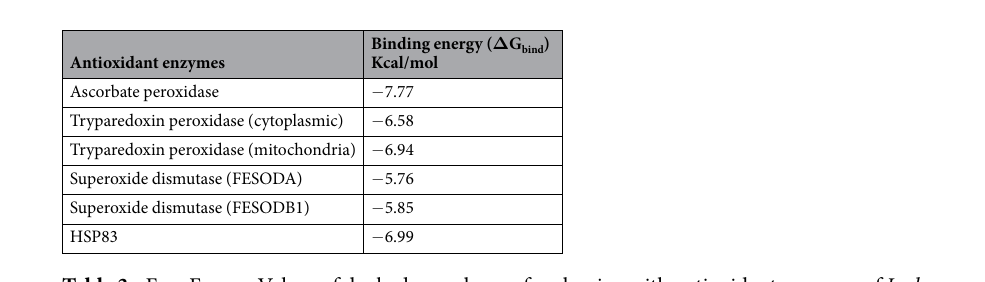
Table 3. Free Energy Values of docked complexes of mahanine with antioxidant enzymes of L. donovani